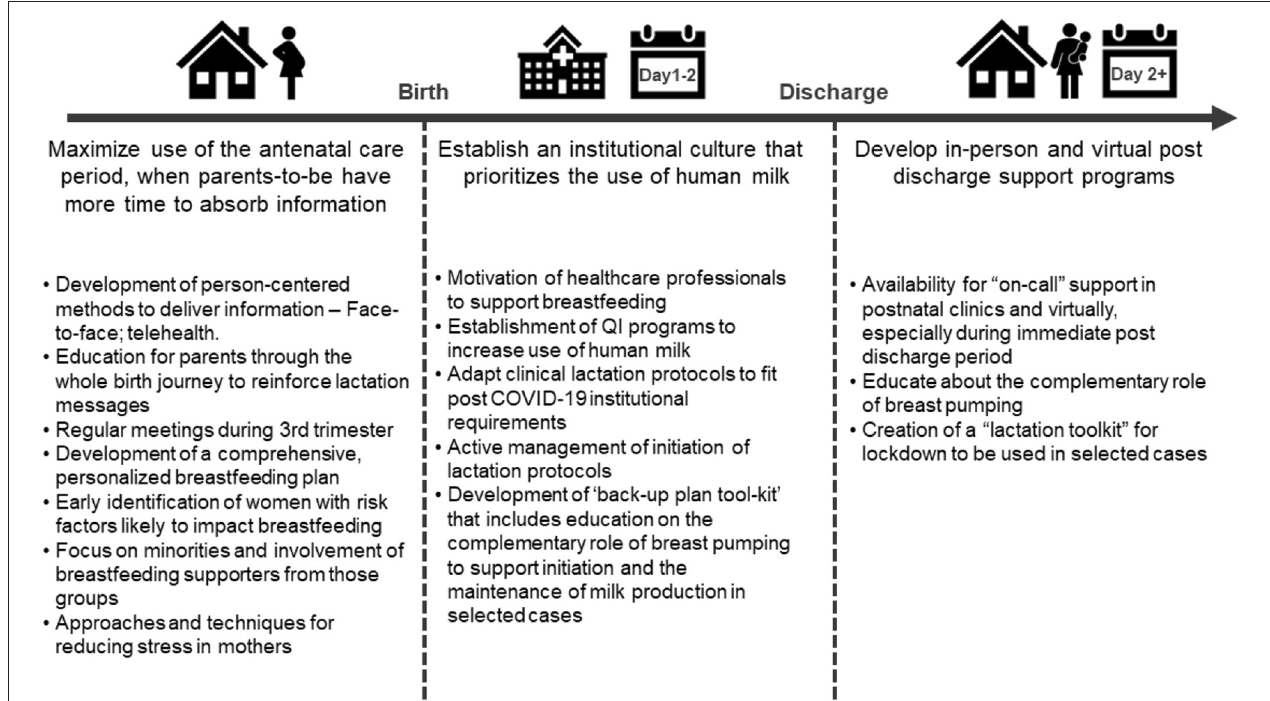
FIGURE 1 | Target clinical practice areas to address in order to maintain the promotion and protection of human milk and breastfeeding in a post COVID-19 era.